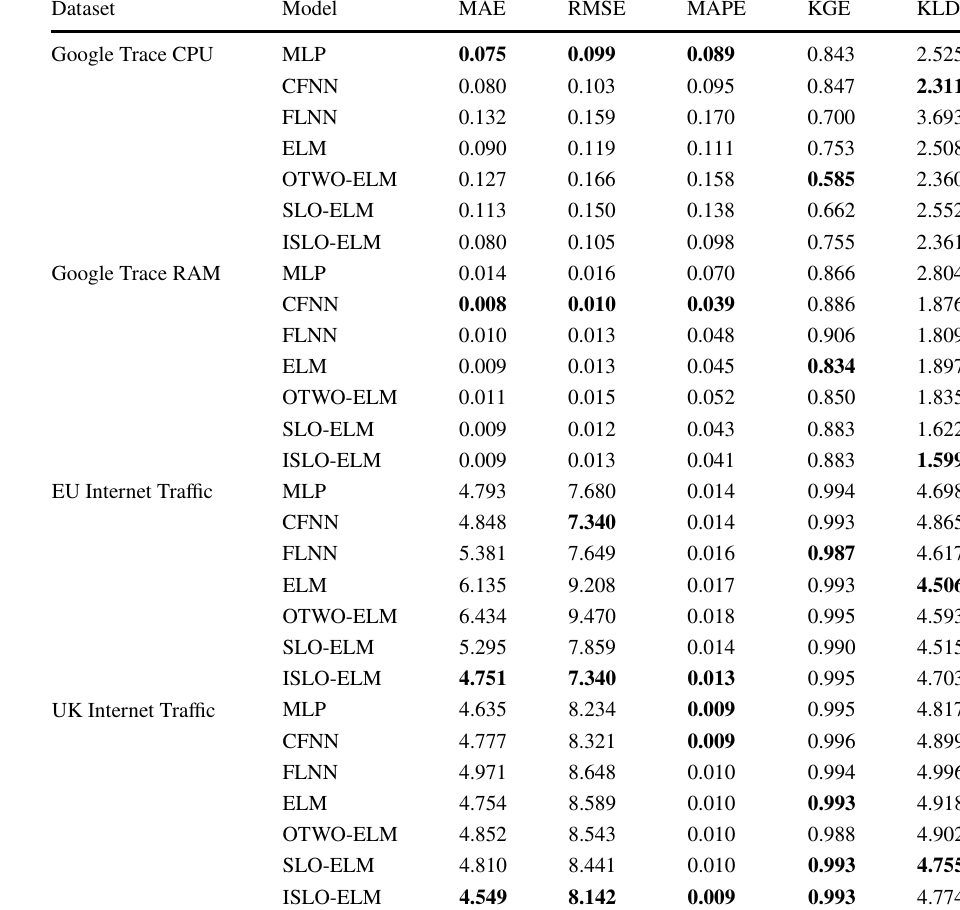
The best value of each metric on each dataset is highlighted (as bold